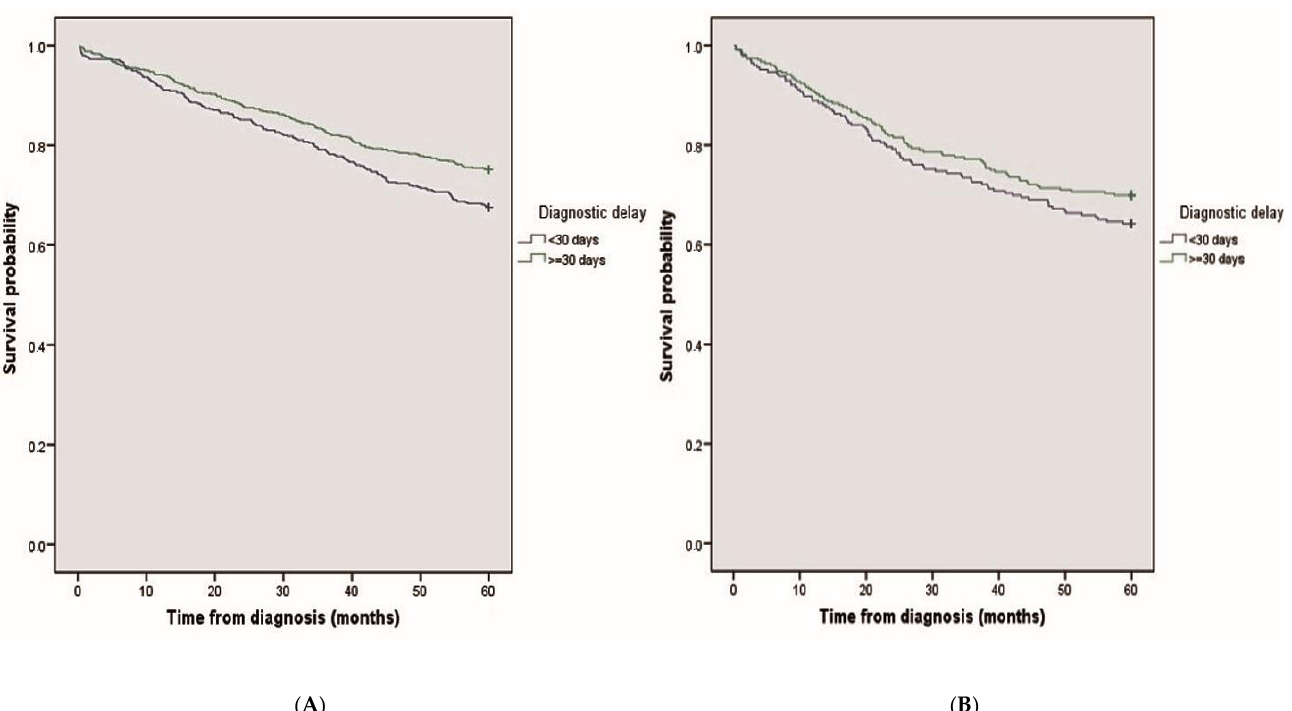
Figure 2. Survival adjusted by tumor location. ( A ) Left colon/rectum; ( B ) right colon. Table 2. Survival analysis according to diagnostic delay, stratified by location.